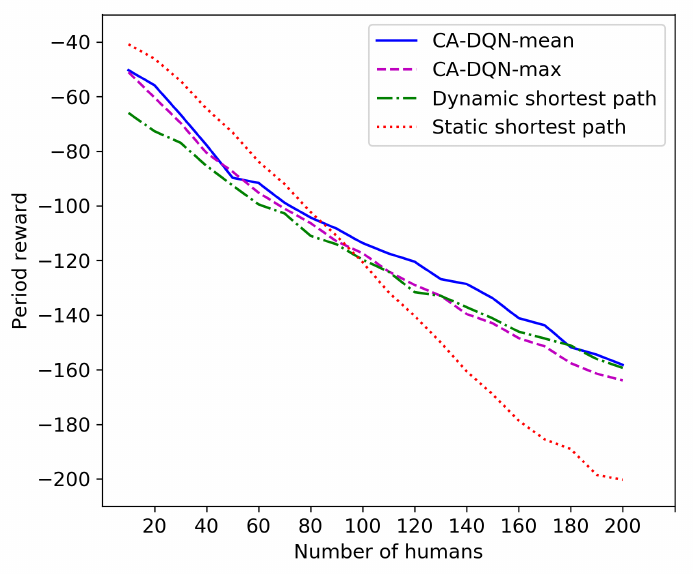
Figure 7. Period reward with varying number of